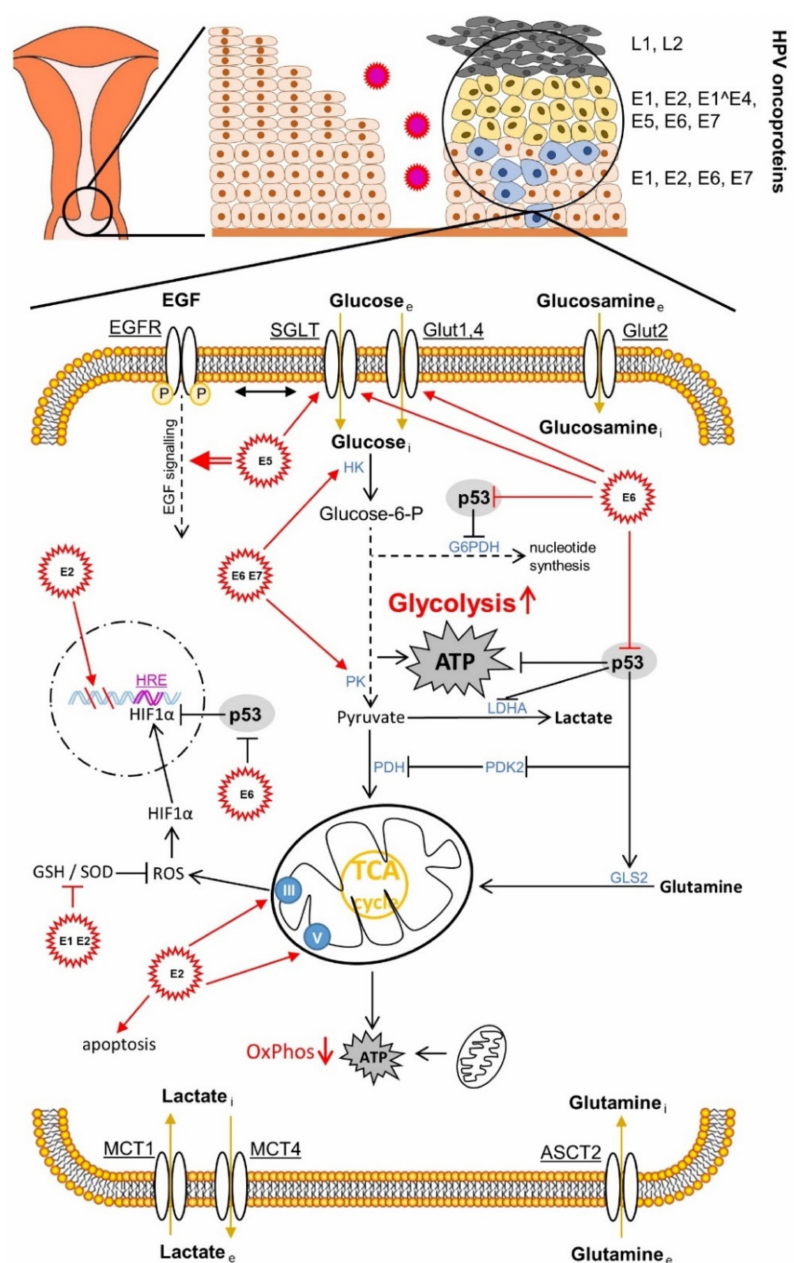
Figure 1. Effects of human papillomavirus (HPV) oncoproteins on cervical cancer cell metabolism. The mechanisms shown are mainly described in Section 4.4. ASCT2, amino acid transporter2; EGF, epidermal growth factor. EGF receptor; G6PDH, glucose-6-phosphat-dehydrogenase; GLS2, glutaminase 2; Glut, glucose transporter; GSH, glutathione; HRE, hypoxia response element; HIF1 α , hypoxia-inducible factor 1 α ; HK, hexokinase; LDHA, lactate dehydrogenase A; MCT, mono- carboxylate transporter; OxPhos, oxidative phosphorylation; PDH, pyruvate dehydrogenase; PK, pyruvate kinase; PDK2, pyruvate dehydrogenase kinase isoform 2; ROS, reactive oxygen species; SGLT, sodium glucose transporter; SOD, superoxide